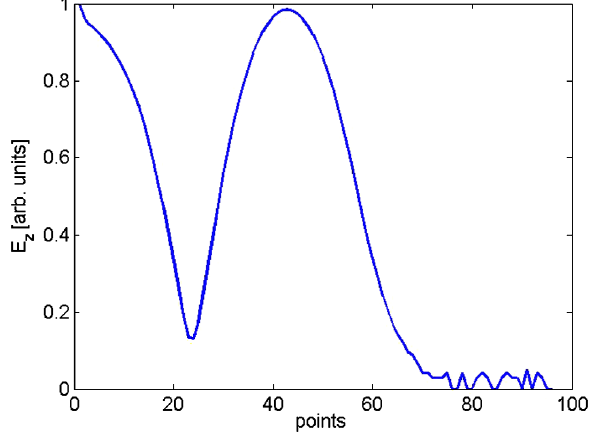
FIG. 9. Measured accelerating field profile after tuning.